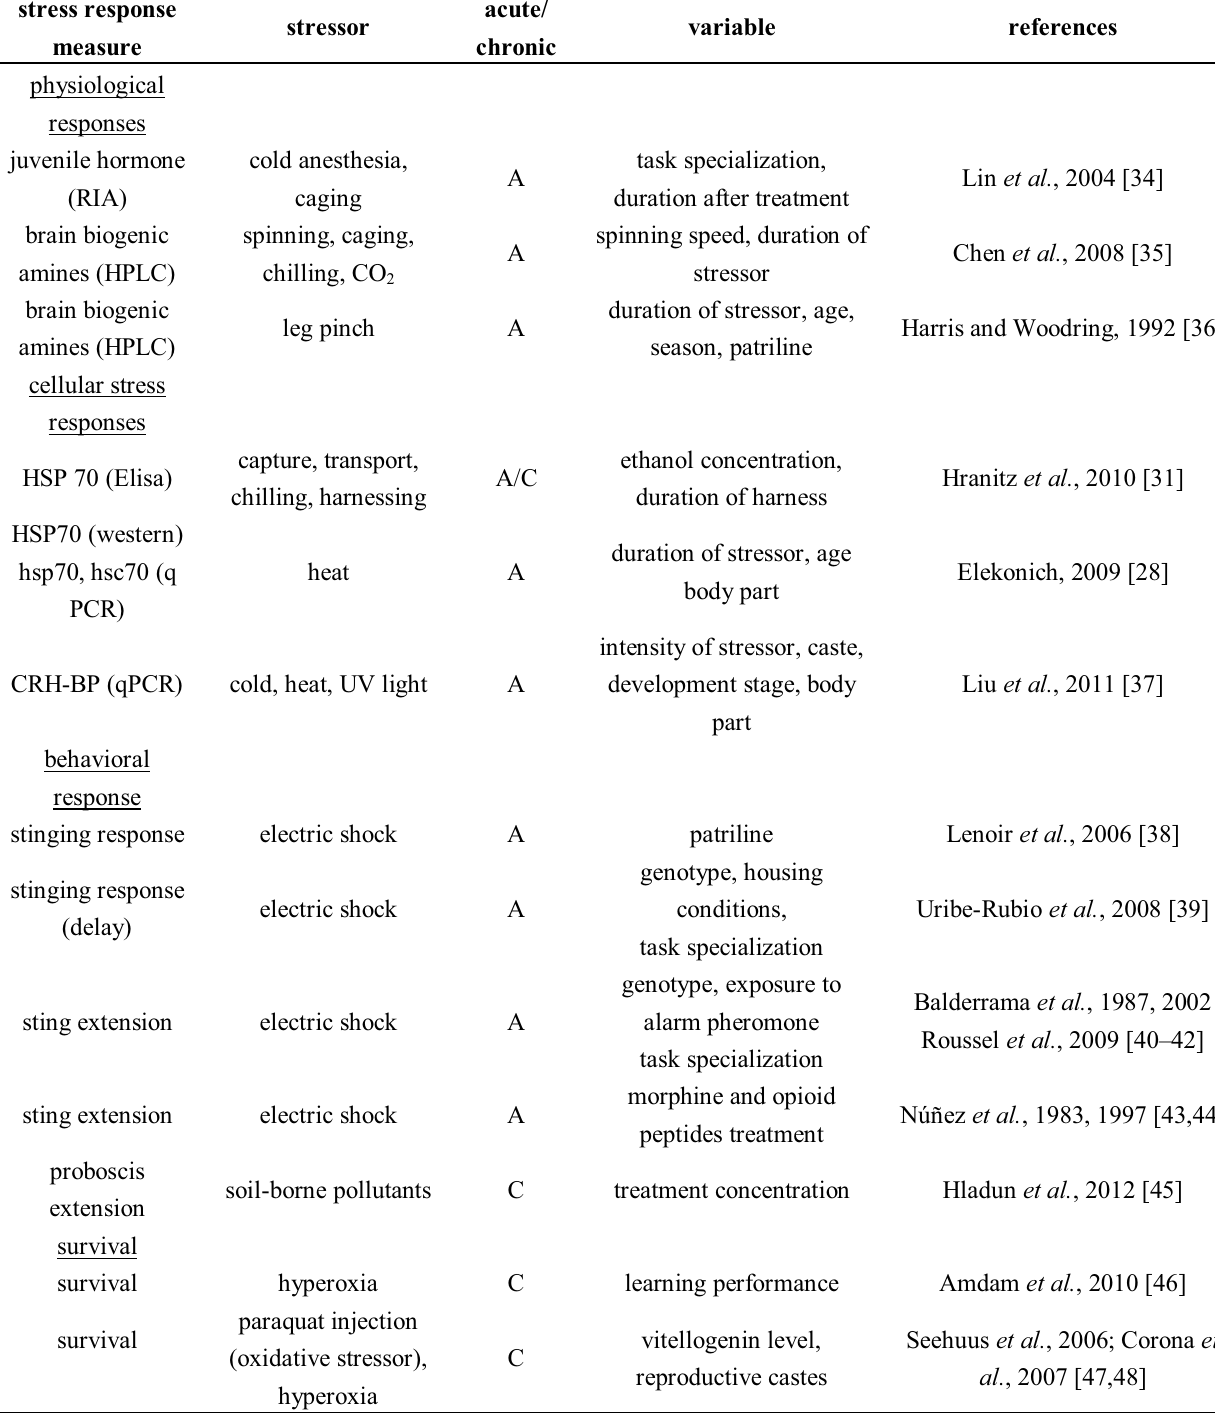
Table 1. Stress response measures used in honey bees. This inventory illustrates the broad diversity of methods used to evaluate stress in honey bees. The table is divided into four parts, depending on the measure used: behavioral, physiological, cellular and survival. In the absence of an objective distinction between chronic and acute stressors, here we qualify stressors ingested or applied continuously during at least four hours as chronic (C); otherwise they are qualified as acute